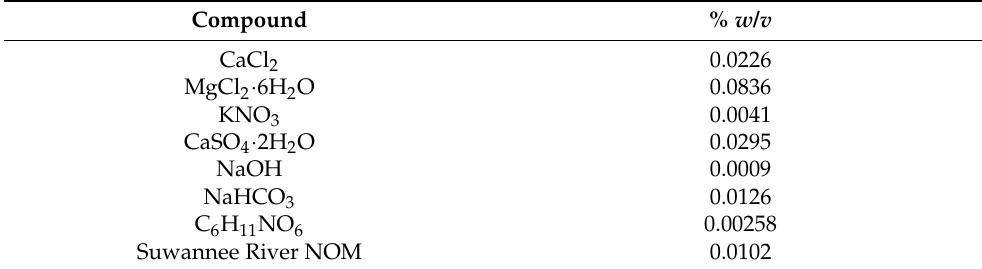
Table 2. Composition of standardized water matrix comprising Suwannee River NOM.